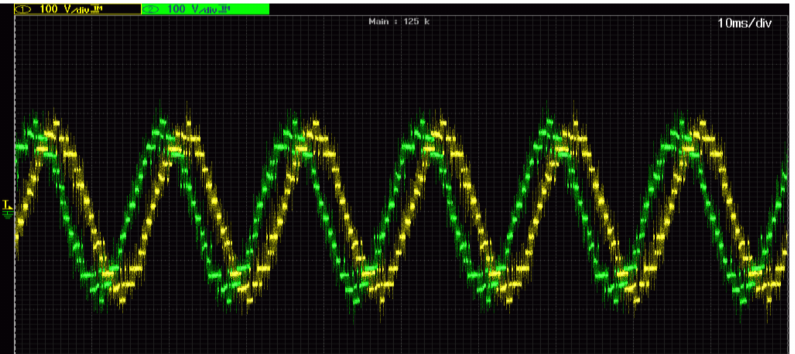
Figure 12. Output voltages V AB and V CB for a modulation index of